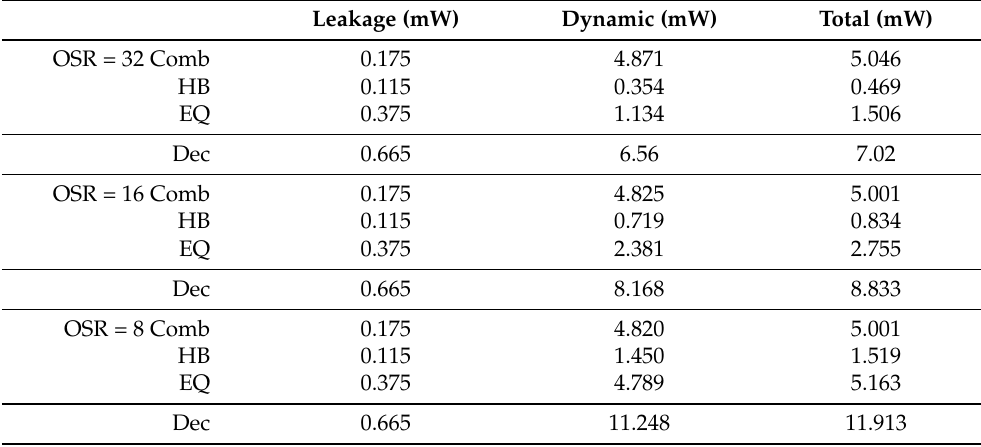
Table 5. Decimator power consumption